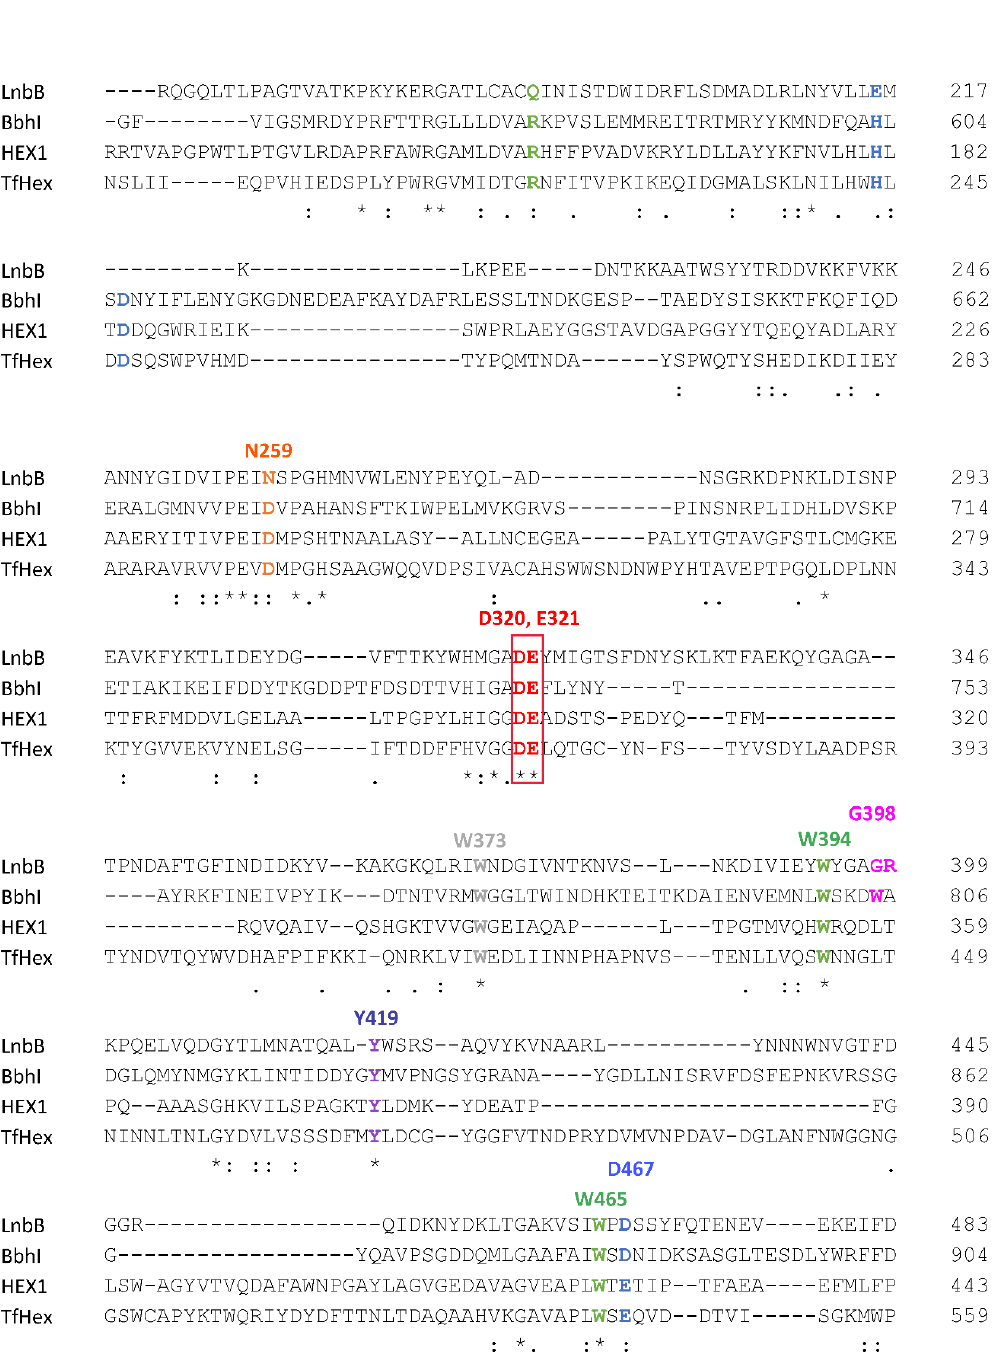
Figure 2. Multiple sequence alignment of LnbB (ABZ78855.1), BbhI (BAI94822.1), HEX1 (AKC34128.1), and β- N -acetylhexosaminidase from Talaromyces flavus ( Tf Hex; AEQ33603.1) using Clustal Omega [25]. The catalytic Asp–Glu pair is highlighted in red, while the substrate-stabilizing Tyr is marked in purple; mutation of the latter improved transglycosylation in BbhI, LnbB, and Tf Hex [15,17,22]. Conserved residues found to improve BbhI transglycosylation yield through conservative substitutions are marked in green, whereas those marked in blue did not improve BbhI transglycosylation yields [26]. An additional, conserved residue (W373) identified in the current work by multiple sequence alignment of all GH20s characterized in the CAZy database is highlighted in grey. Similarly, N259 (orange) is not well conserved across GH20 but is completely conserved among putative Actinobacteria LNBases. Residues marked in magenta suggest a role for an Arg residue on the border of the active site for improved transglycosylation in HEX1 and in BbhI [8,27,28]. Residue numbering for each sequence is indicated on the right side of the alignment. Residues selected for mutation in LnbB in the current work are labelled above the alignment. “*” below sequences indicate that residue is conserved in all sequences in the alignment; “:” indicates that conserved substitutions are found; “.” indicates that semi-conserved substitutions are present.